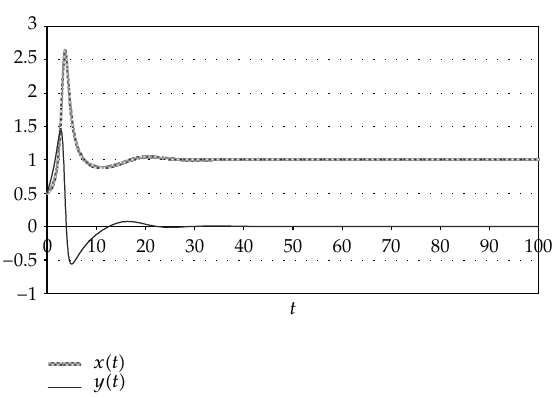
Figure 10: x (cid:2) 0 (cid:3) (cid:6) 0.5, y (cid:2) 0 (cid:3) (cid:6) 0.5, a (cid:6) 0.1, b (cid:6) 0.4, alpha (cid:6) 0.9.